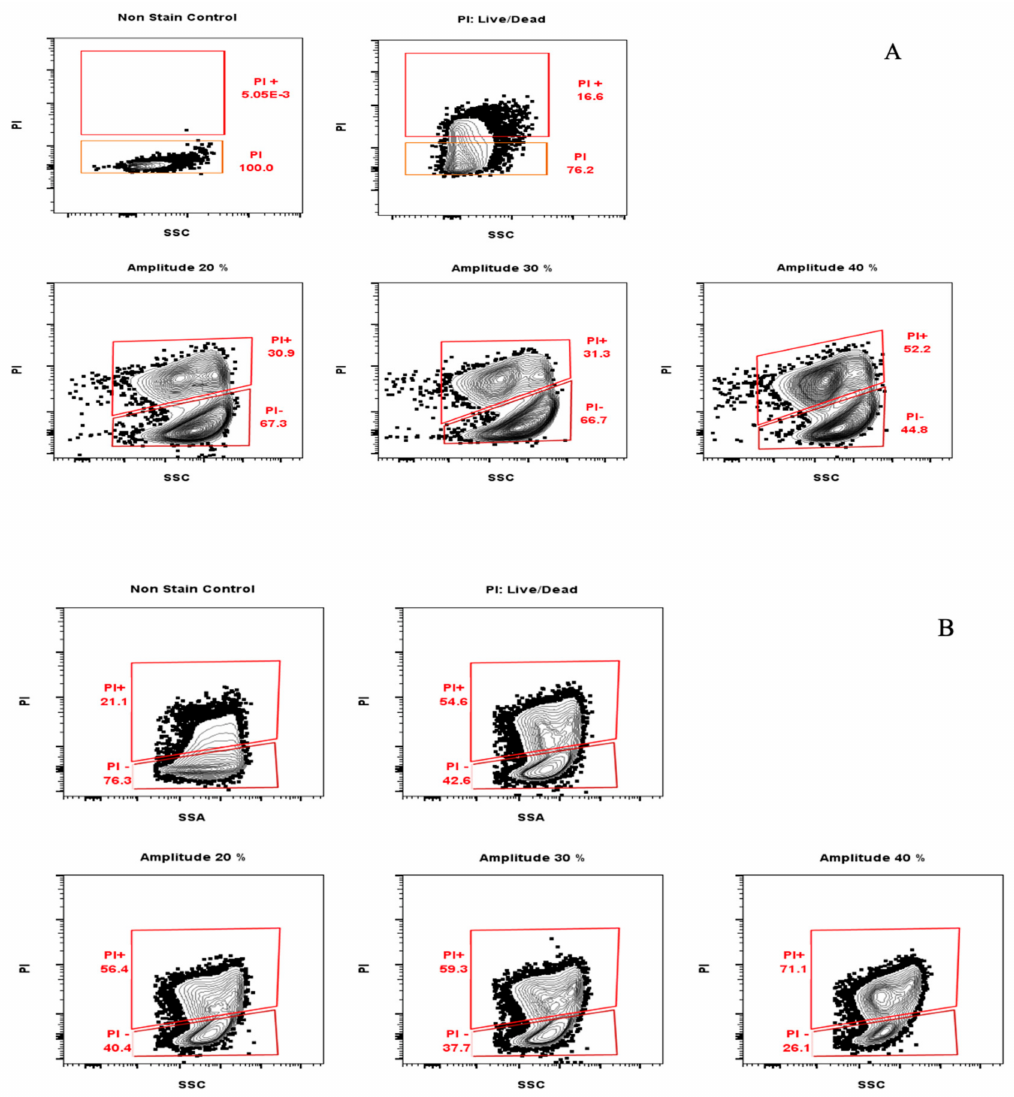
Figure 3. Flow cytometric analysis of probiotics undergoing ultrasound treatment. ( A ) L. acidophilus and ( B ) L. helveticus